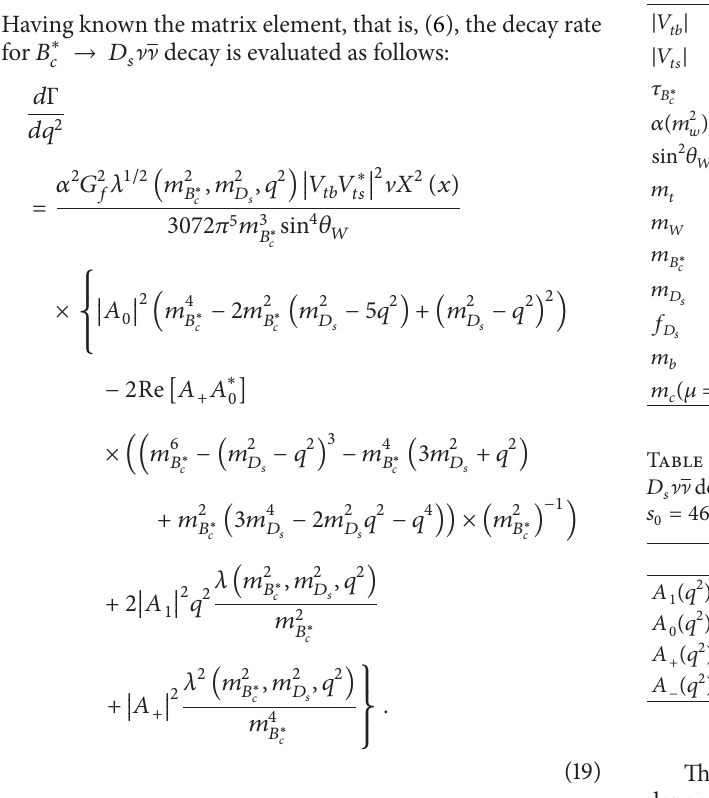
Table 1: The values of the input parameters [24].